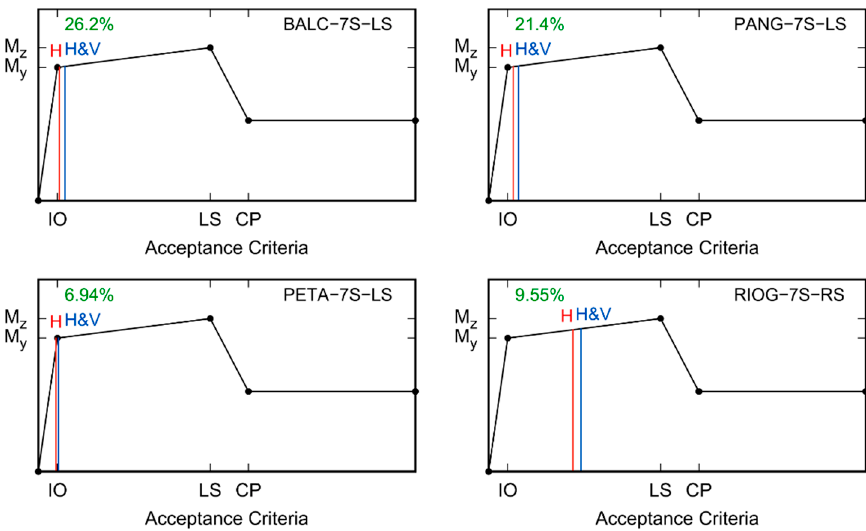
Figure 25. Examples of acceptance criteria for the 8-story building. Part 2.